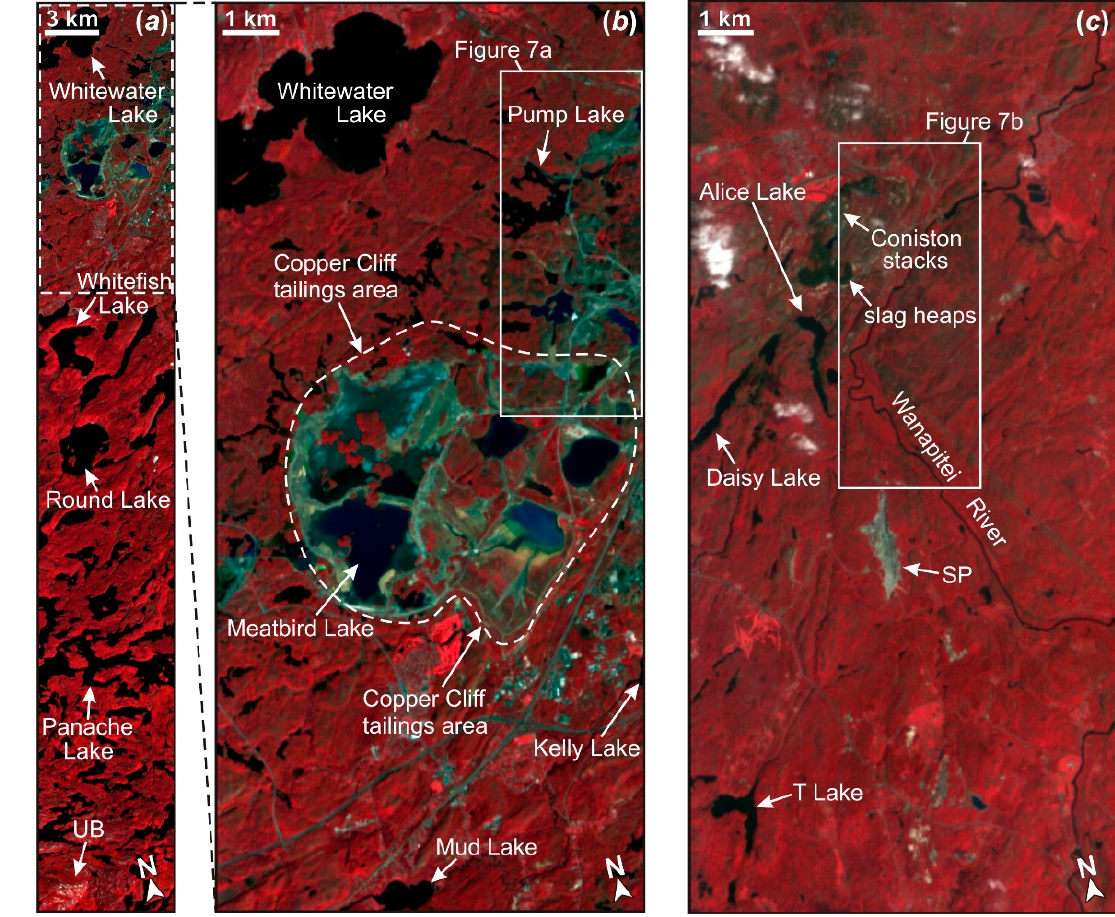
Figure 6. Hyperion hyperspectral data are available for areas near the Copper Cliff ( a and b ) and Coniston ( c ) smelters. The above images are Hyperion color-infrared composites (red = 753 nm; green = 651 nm; blue = 560 nm) that highlight vegetative cover in shades of red. The outlines of areas depicted in the aerial orthophotos of Figure 7 are indicated. A prominent exposure of uncoated bedrock in the southernmost part of the Copper Cliff study area ( a ) is labeled “UB”, and a large sediment pit in the central part of the Coniston study area ( c ) is labeled “SP”. Cloud cover is present in the northern half of the Coniston study area (white irregularly-shaped patches). Image footprints and smelter stack locations are given in Figure 1.